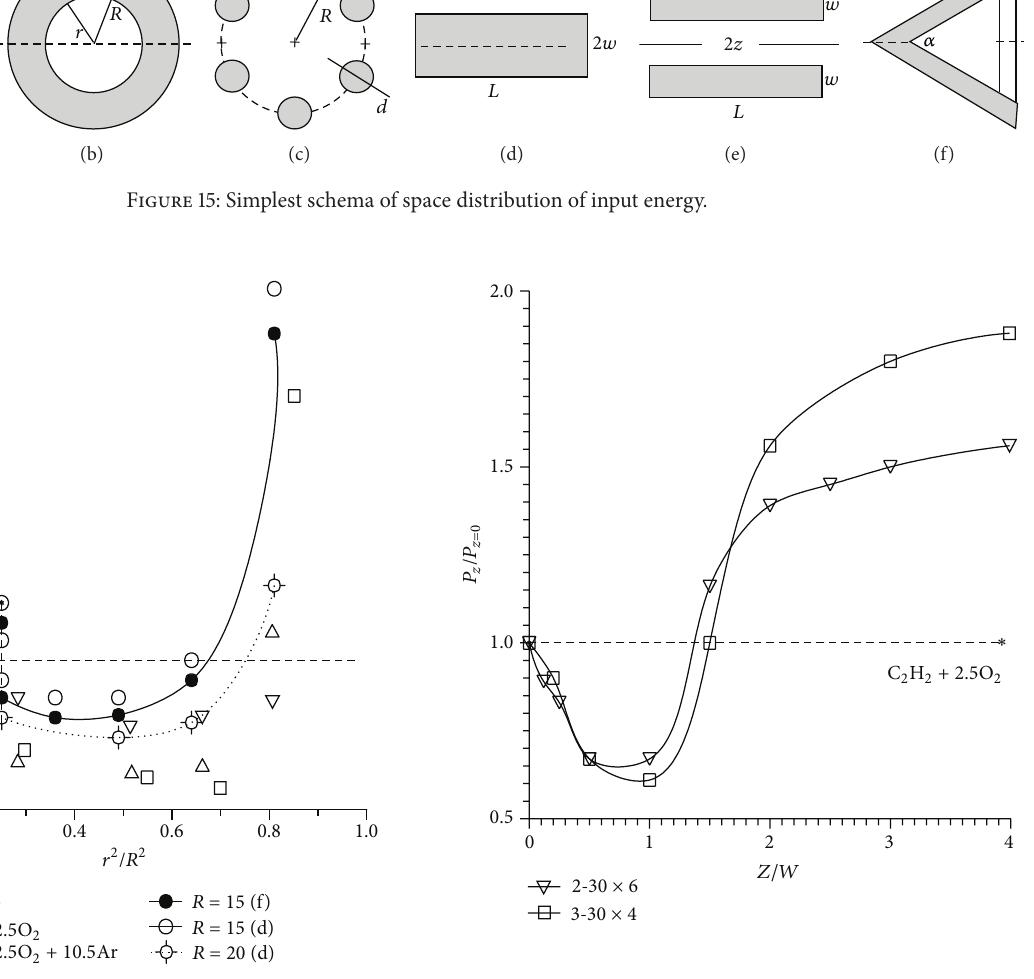
Figure 17: Initial pressure of mixture for critical initiation of quasi-cylindrical DW by two or three parallel charges Figure 15(f) (normalized on pressure for the summary charge Figure 15(d)) on distance among charges (normalized on character width of individual